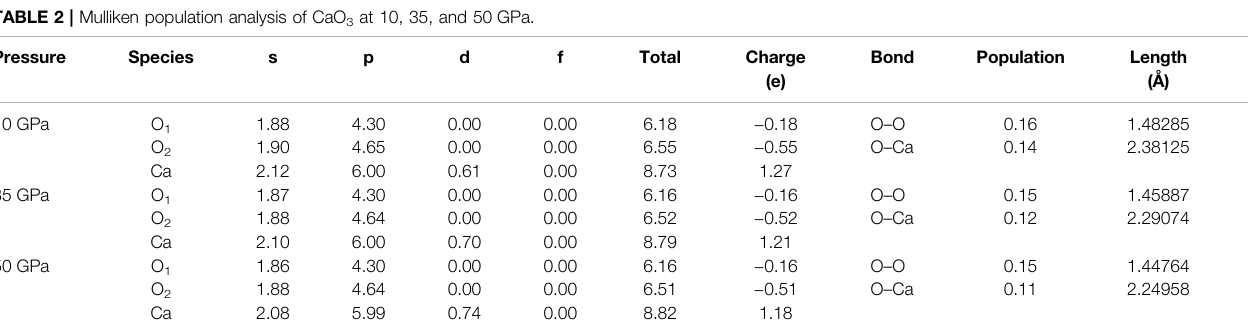
TABLE 2 | Mulliken population analysis of CaO 3 at 10, 35, and 50 GPa. Pressure